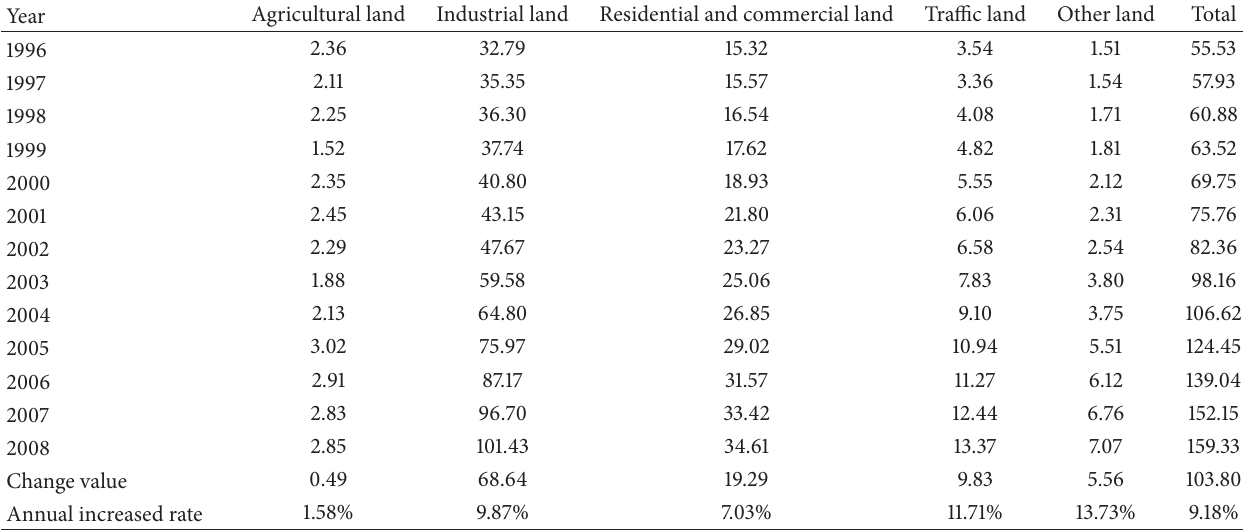
Table 5: Energy-related carbon emissions in different land use types during 1996–2008 (million